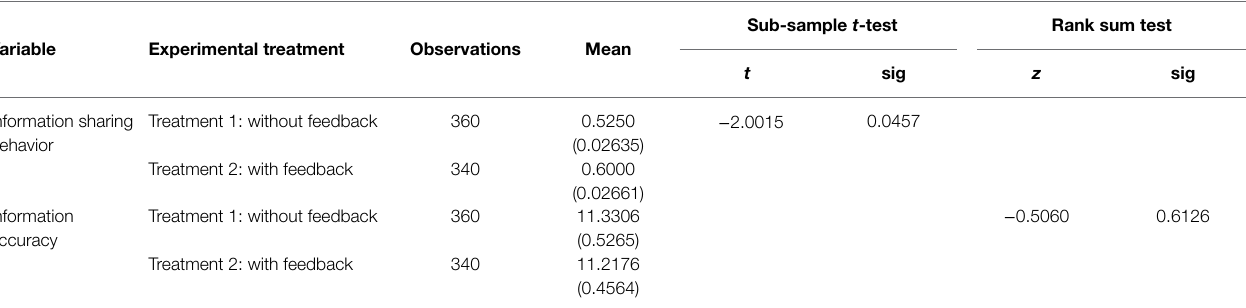
TABLE 4 | Comparison of information sharing behavior in treatments 1 and